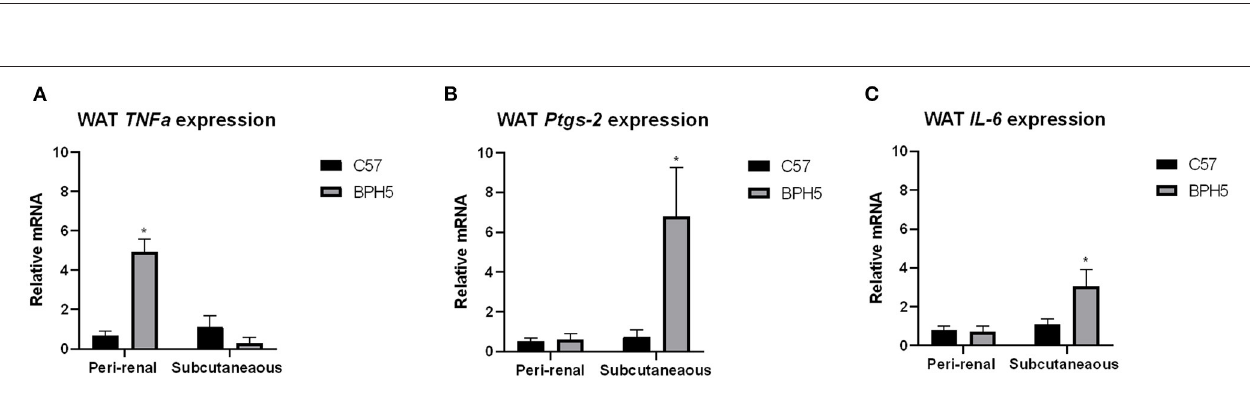
Frontiers in Pediatrics |